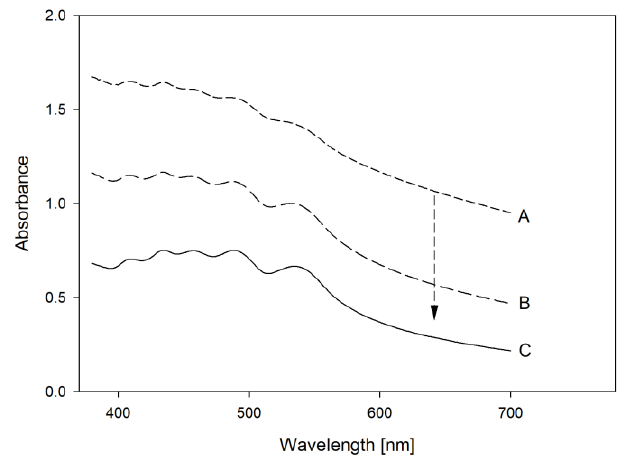
Figure 1. UV/Vis spectra of a carrot concentrate diluted in water (A), diluted in a water: sugar solution (1:1) (B), and diluted in a 69 °Bx sugar solution (C).